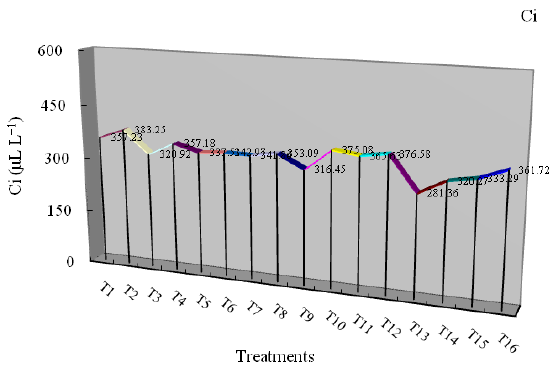
Figure 4. The effect of electric field on net photosynthetic rate (Pn), stomatal conductance (Gs), transpiration rate (Tr), and intercellular CO 2 concentration (Ci). Values represent the mean.